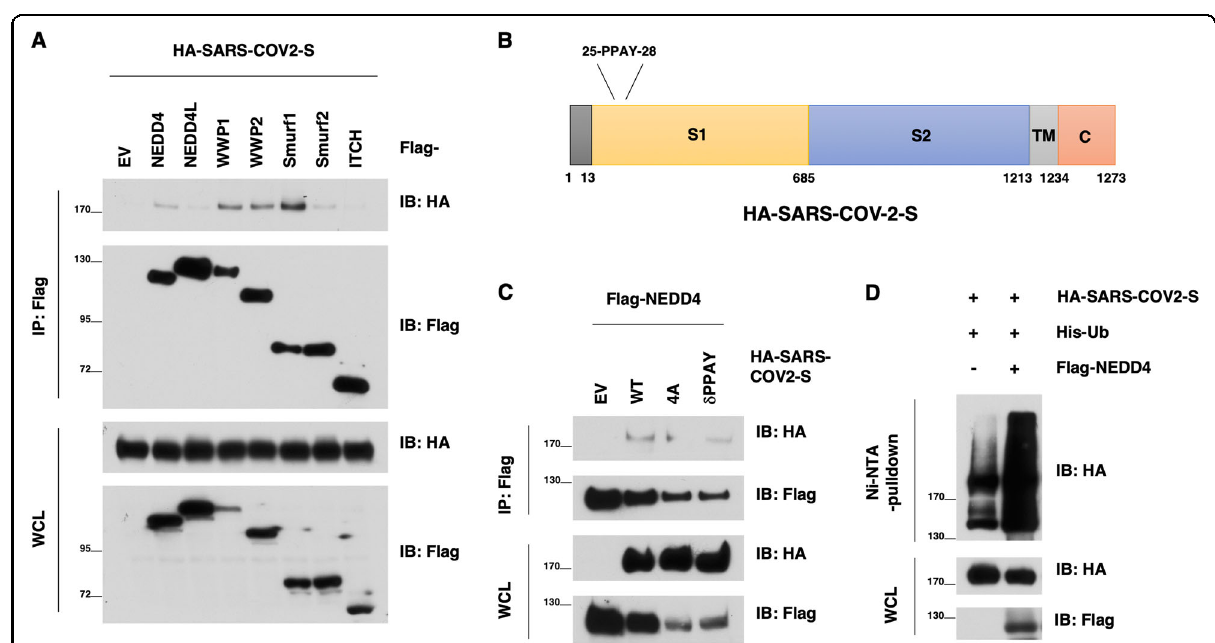
Fig. 1 NEDD4 binds and ubiquitinates the SARS-CoV-2 S protein. A Immunoblotting (IB) of fl ag-immunoprecipates (IP) and whole cell lysis (WCL) derived from HEK293T cells that were transfected with HA-SARS-CoV-2 S and indicated NEDD4 family members. B A schematic diagram to show the PPxY motif in the SARS-CoV-2 S protein. C IB of fl ag-immunoprecipates and WCL derived from HEK293T cells that were transfected with NEDD4 and SARS-CoV-2 S WT or mutants. D IB of Ni-NTA pulldown and WCL derived from HEK293T cells that were transfected with SARS-CoV-2 S and NEDD4 WT (or EV as a negative